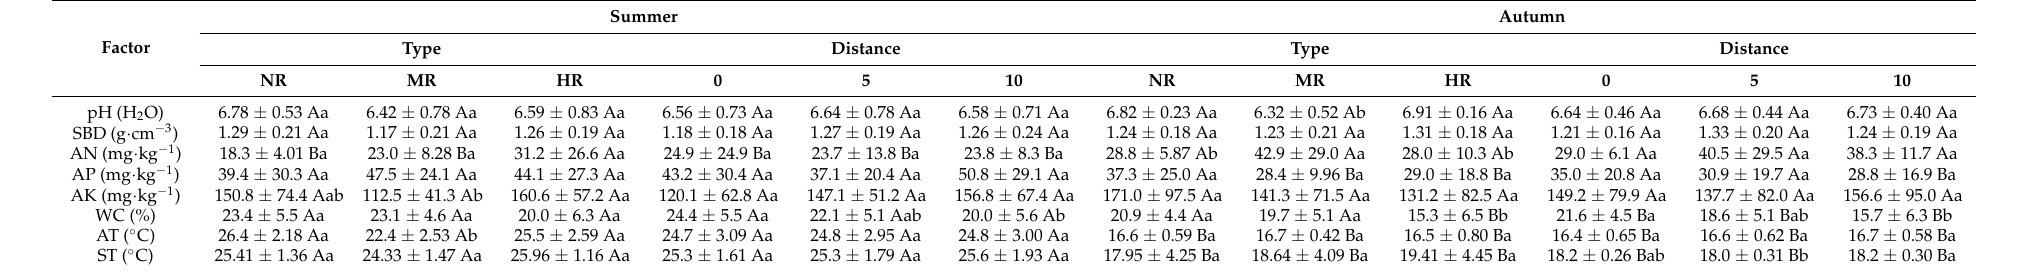
Table A1. Values of environmental variables (mean ± sd) of different revetment types and